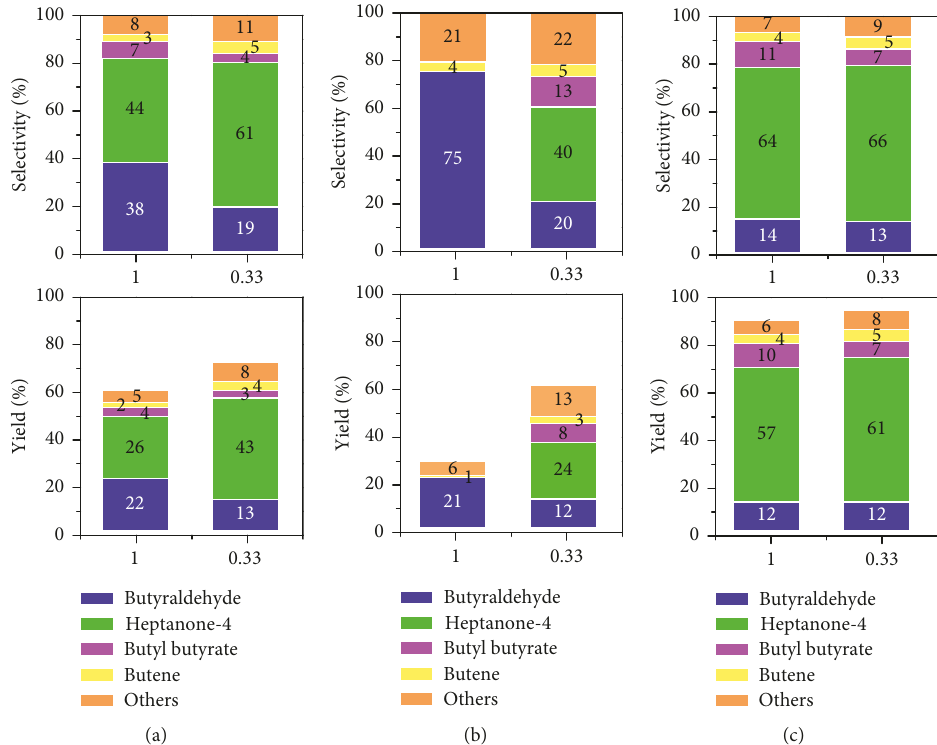
Figure 10: The dependence of the selectivity and the butan-1-ol conversion yield as a function of the contact time of the catalyst (LHSV � 1 or 0.33h − 1 ). (a) P1-C2O4. (b) P2-CO3. (c)